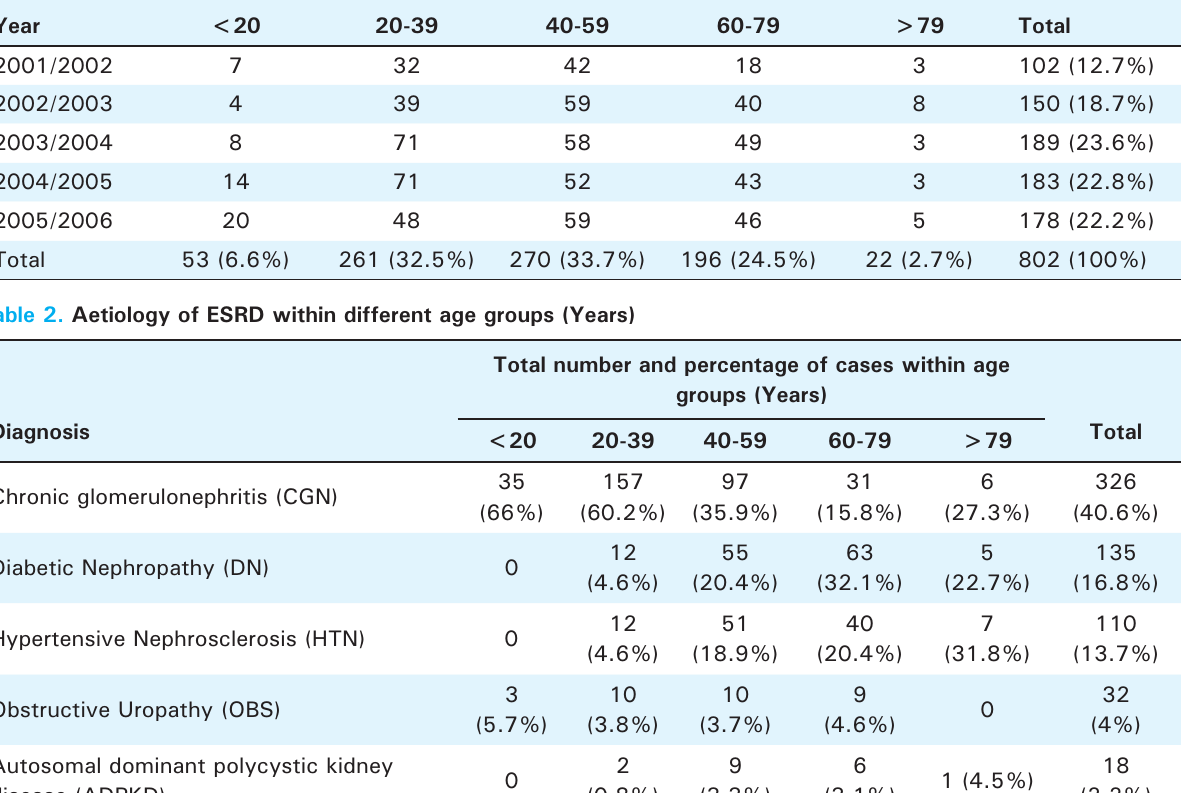
Table 1. Annual ESRD patients according to age group (Years)